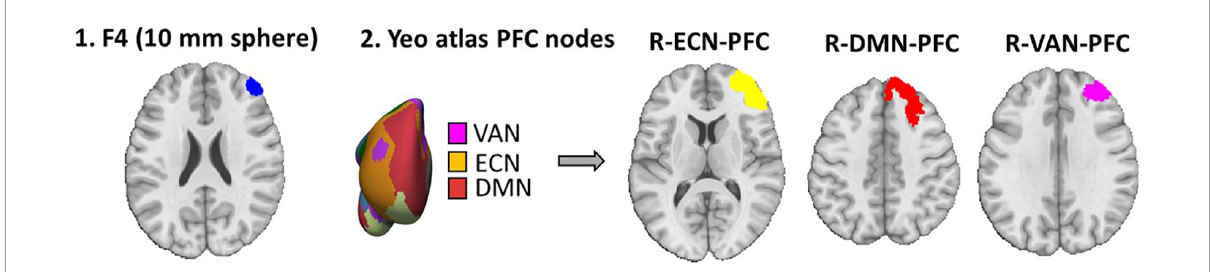
FIGURE2 Seed definition for seed-to-whole brain gPPI. Four seeds were defined 1. A 10 mm sphere around the F4 location (center of the anode electrode in EEG 10–20 standard system) in MNI space. 2. Yeo atlas PFC nodes are visualized over an inflated surface. The PFC nodes in ECN, DMN, and VAN that received the highest electric fields were considered seeds for the seed-to-whole brain gPPI